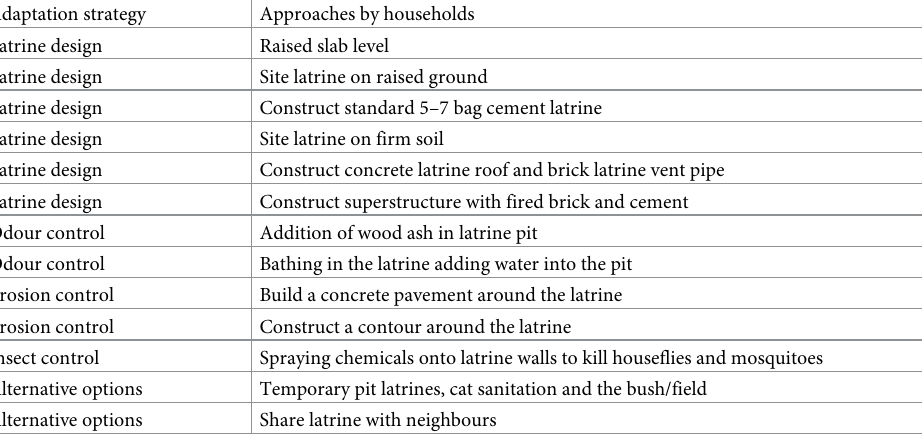
Table 7. Adaptation strategies of BVIP latrine to climate change, Mbire district, northern Zimbabwe (Focus groups), 2021.